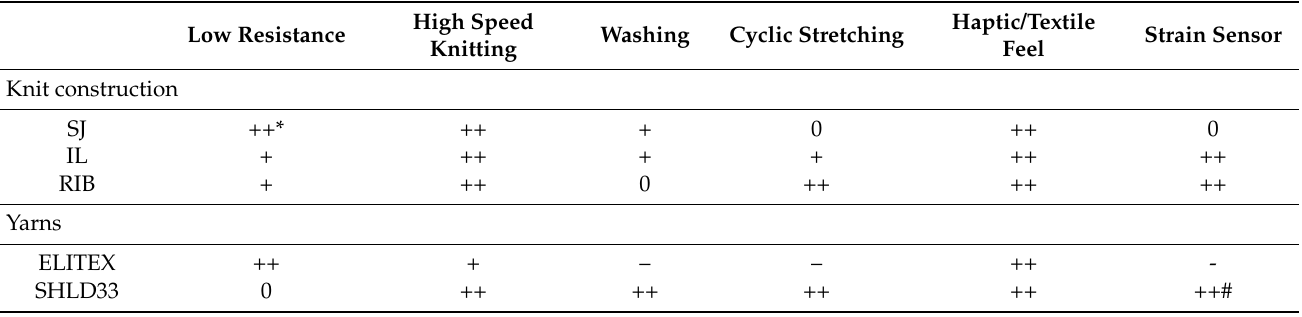
Table 6. Suitability of knit structures and materials for different